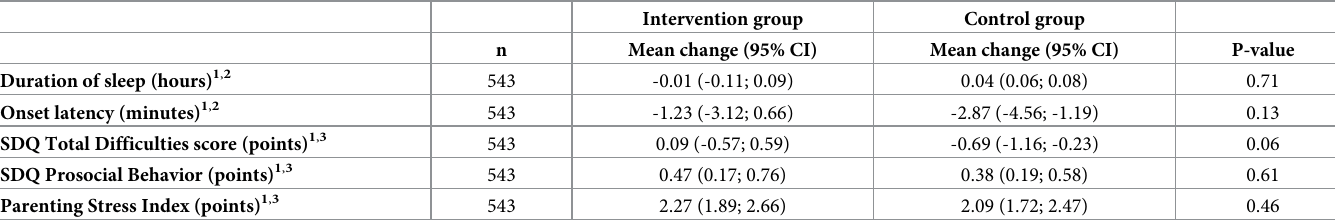
Table 2. Changes in sleep and stress between baseline and follow-up (1.3